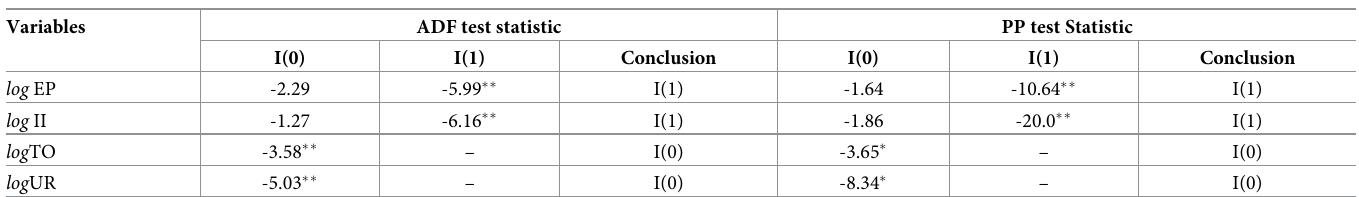
Table 4. Results of unit root